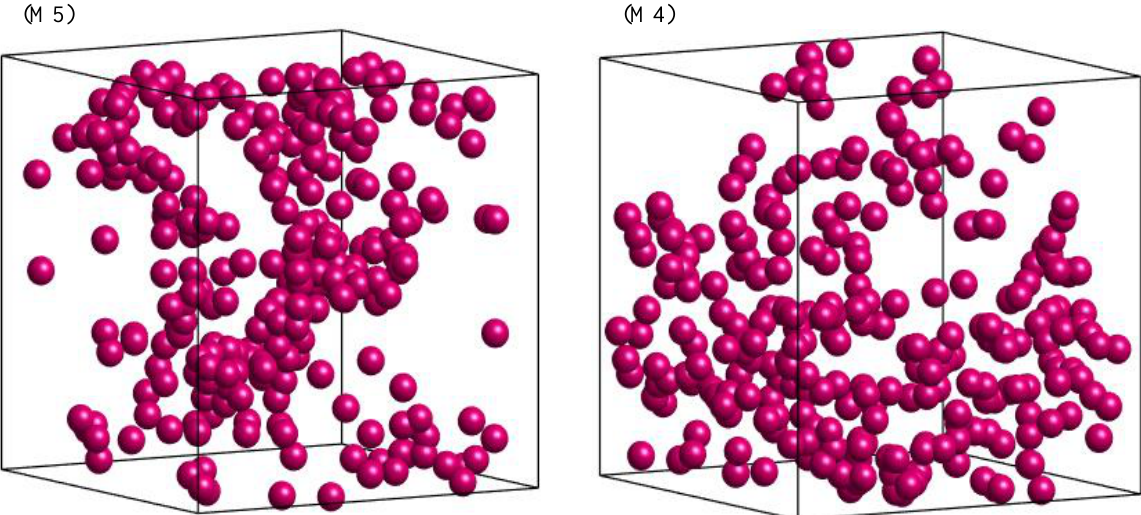
Figure 7. Snapshot of the positions where the reactions happens rarely (M4) and frequently (M5) in the space; here the purple sphere presents the positions of